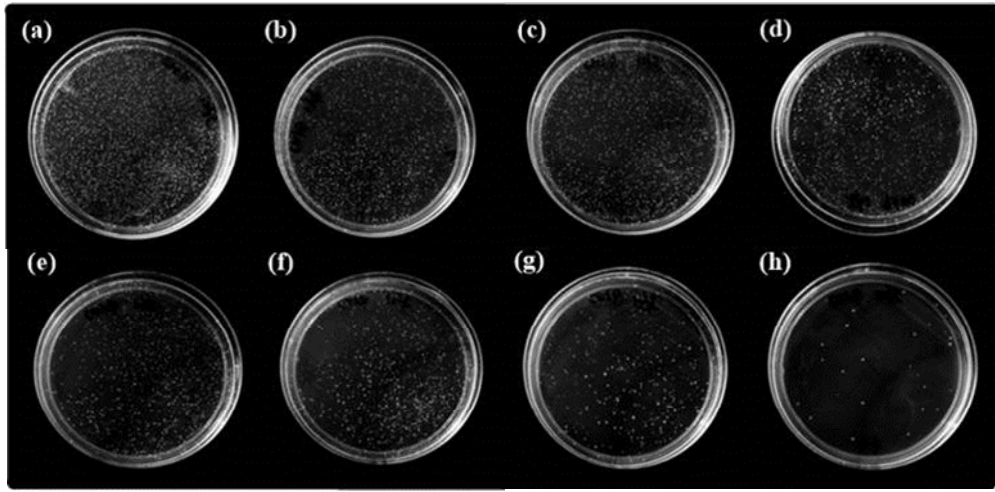
Figure 8. Sterilizing effect on Escherichia coli achieved by atmospheric air glow ‐ like plasmas: ( a ) Control; ( b ) 0.5 s; ( c ) 1 s; ( d ) 2 s; ( e ) 4 s; ( f ) 8 s; ( g ) 16 s; ( h ) 32 s.